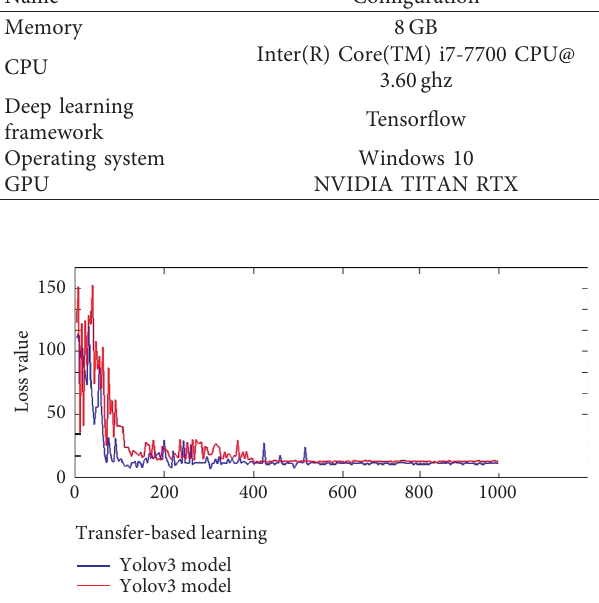
Figure 6: Two yolov3 models loss